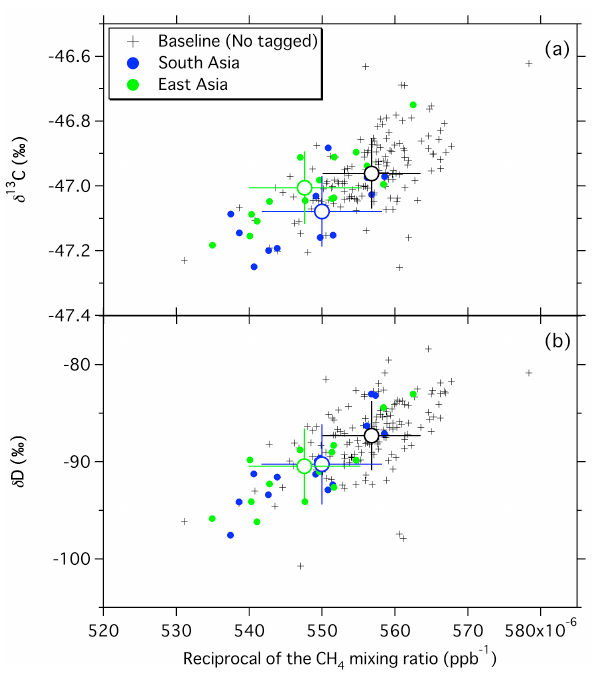
Fig. 7. Plots for (a) δ 13 C and (b) δ D relative to the reciprocal of the CH 4 mixing ratio for the UT at 15 ◦ –32 ◦ N. All data plotted were categorized as “Baseline” (black crosses), “South Asia” (blue closed circles) or “East Asia” (green closed circles) based on the tagged tracer experiments. Also shown are the average values of the data for the respective categories (open circles).